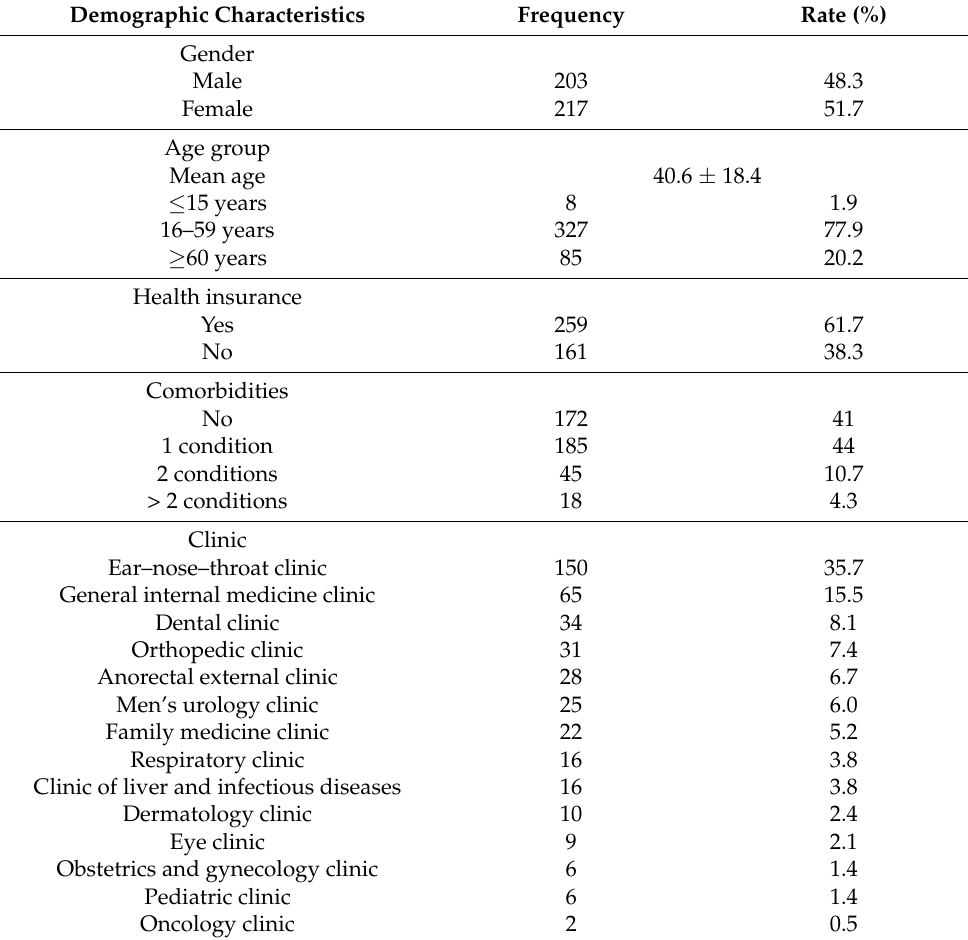
Table 1. Study population’s